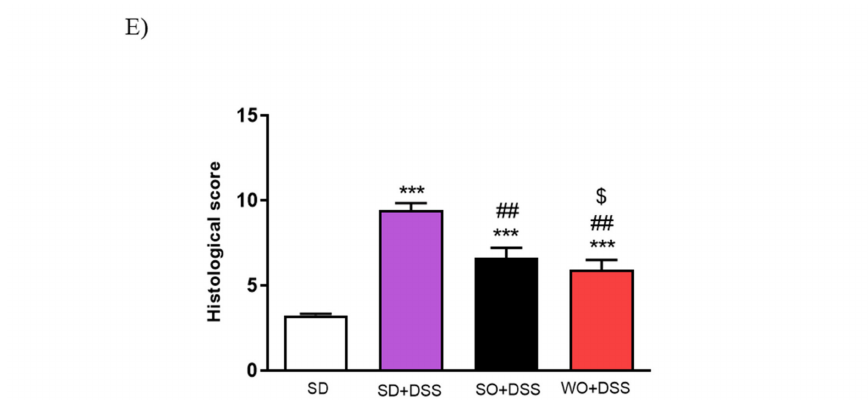
Figure 4. Representative micrographs of hematoxylin and eosin-stained sections of distal colon from ( A ) SD, ( B ) SD + DSS, ( C ) SO + DSS, ( D ) WO + DSS, and microscopic total damage score ( E ). Scale bar = 100 µ m. Data represent mean ± SEM, n = 8. *** p < 0.001, as compared to control; ## p < 0.01, ### p < 0.001 as compared to DSS; $ p < 0.05, as compared to sunflower oil (SO).